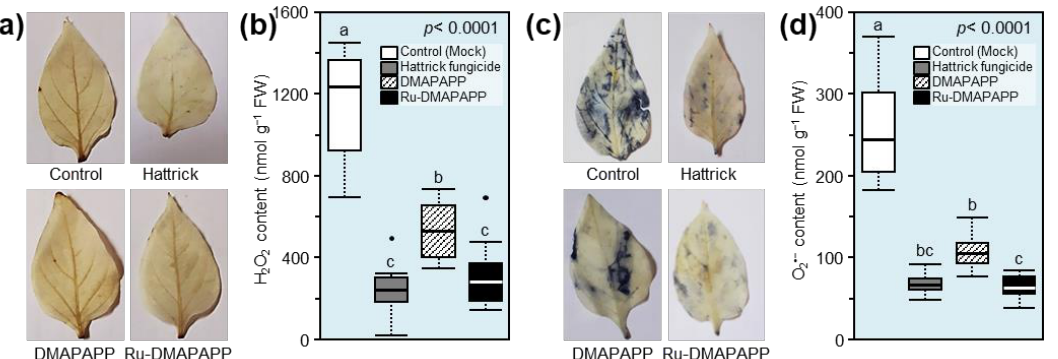
Figure 5. Effect of two bis-chalcone derivatives, DMAPAPP and Ru-DMAPAPP, on the oxidative stress associated with fusarium wilt disease caused by Fusarium equiseti on pepper plants under greenhouse conditions. ( a ) In situ histochemical visualization of superoxide anion (O 2 •− ) using NBT-based staining at 72 h post-treatment (hpt) with DMAPAPP and Ru-DMAPAPP. ( b ) O 2 •− content (nmol · g − 1 FW) after the treatment with DMAPAPP and Ru-DMAPAPP. ( c ) In situ histochemical localization of hydrogen peroxide (H 2 O 2 ) using DAB-based staining at 72 hpt with DMAPAPP and Ru-DMAPAPP. ( d ) H 2 O 2 content (nmol · g − 1 FW) after the treatment with DMAPAPP and Ru-DMAPAPP. Boxes show the interquartile ranges including values from 25 to 75%, horizontal thick lines indicate the medians, and whiskers reflect the highest and the lowest values of the data. Different letters indicate statistically significant differences between treatments using the Tukey–Kramer honestly significant difference test (Tukey HSD; p < 0.05).